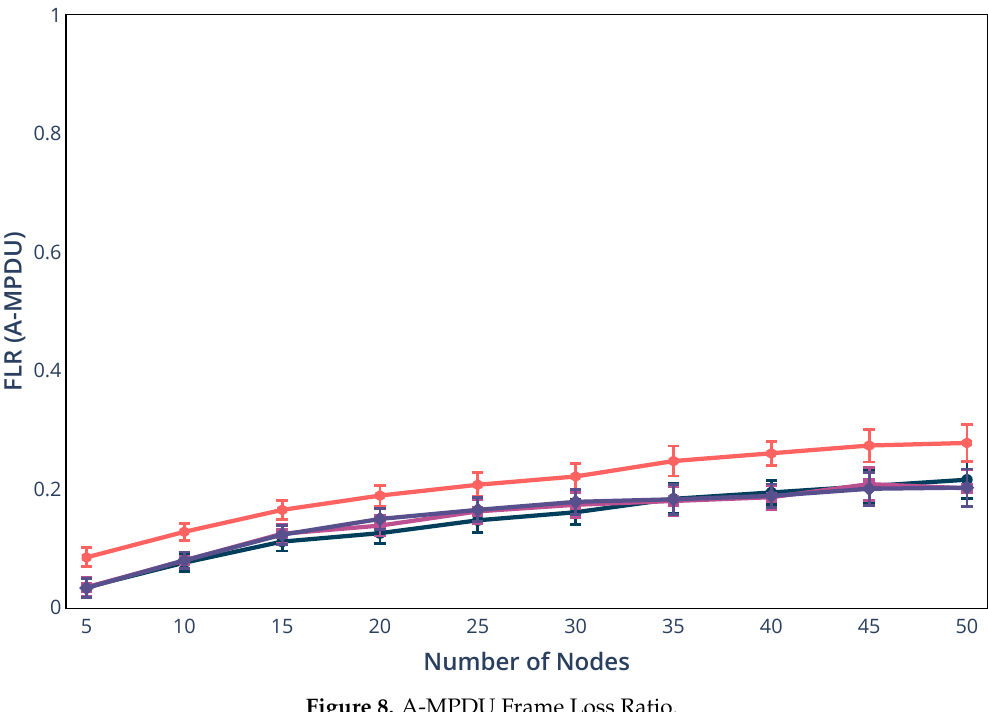
Figure 8. A-MPDU Frame Loss Ratio.